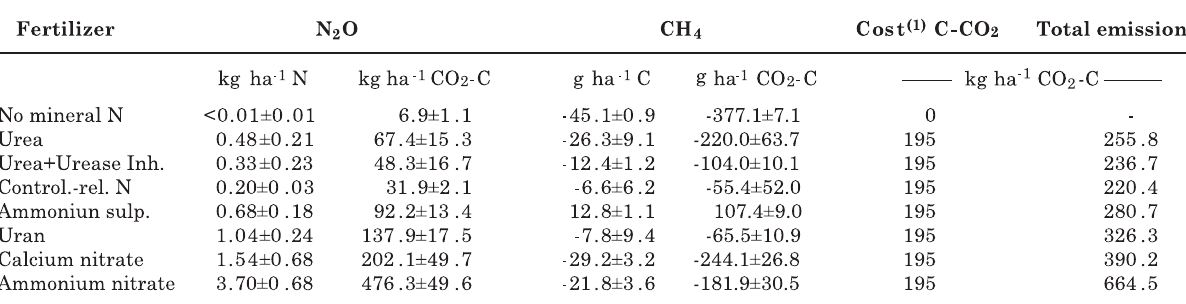
Table 4. Accumulated N application, their correspondent values in equivalent CO greenhouse gases emission (N